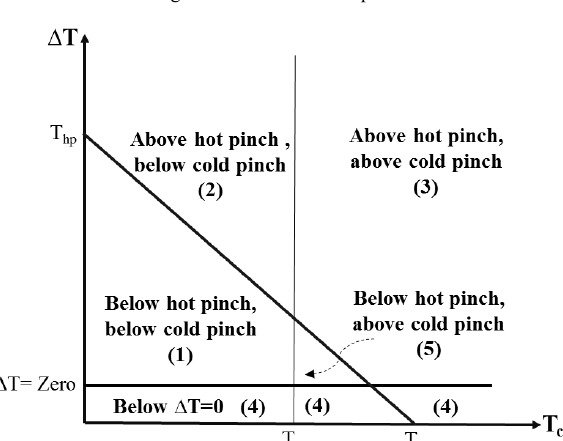
Figure 3. Locus of each point